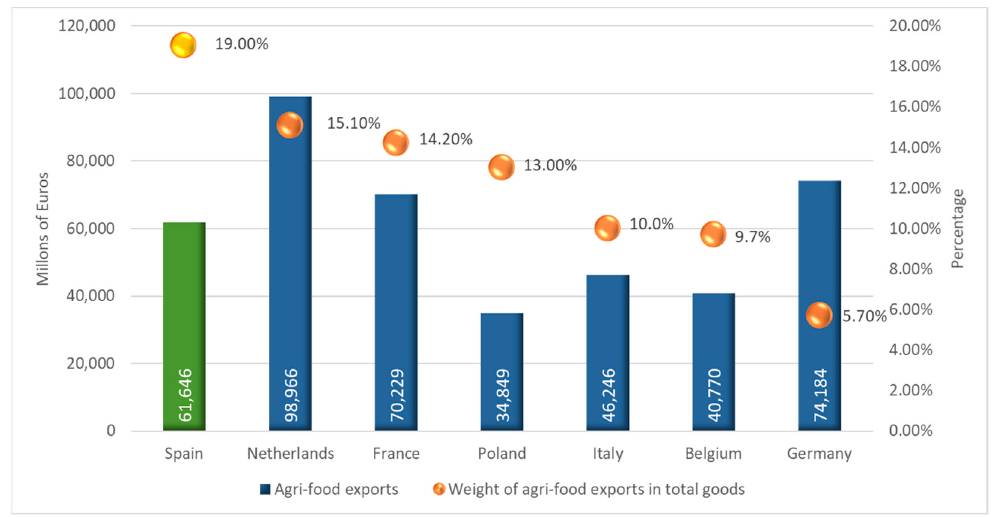
Figure 3. Agri-food exports (millions of euros) and the percentage that they represent over the total of goods of some of the EU-28 countries (2021) [25].